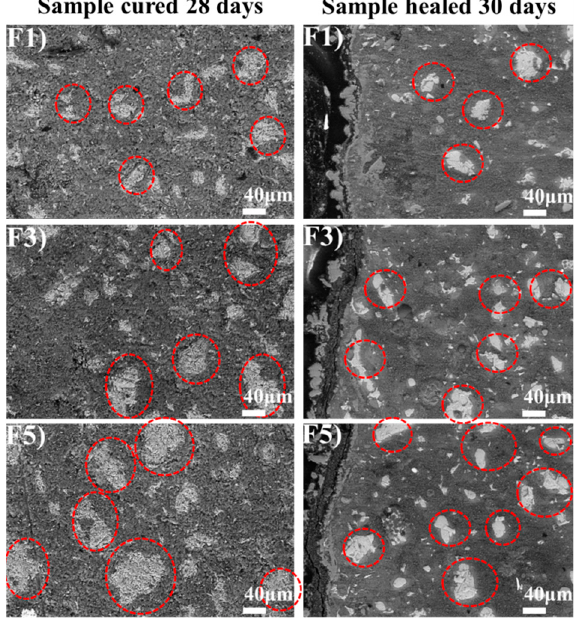
Figure 14. BSE image analysis of cement paste. (F1, F3 and F5 are the group numbers of cement particles with the average size of 22.82 μm, 39.10 μm and 60.51 μm, respectively .)